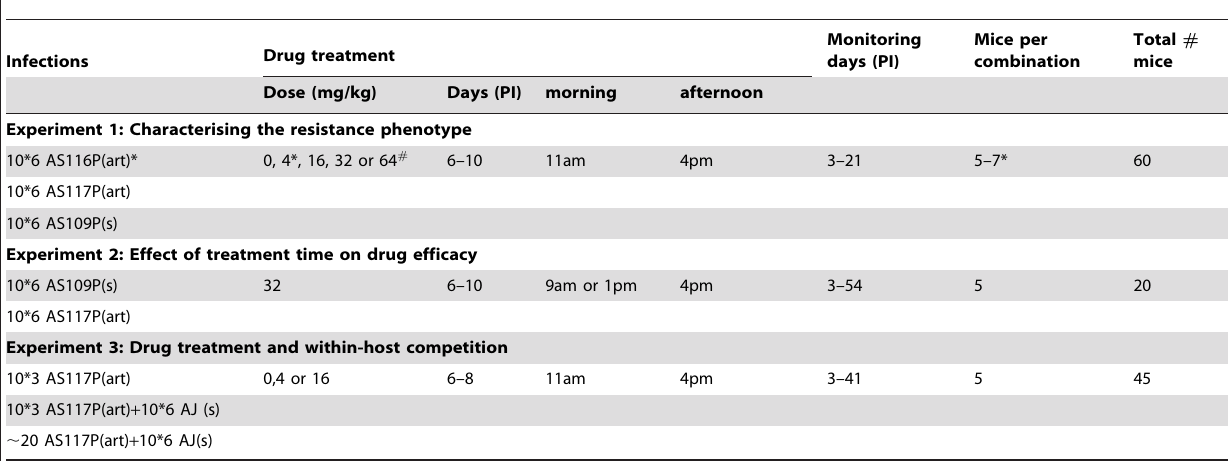
Table 1. Treatment groups and sample